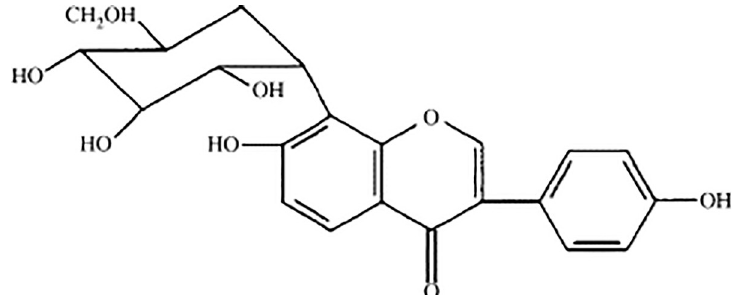
Fig 3. Chemical structure of